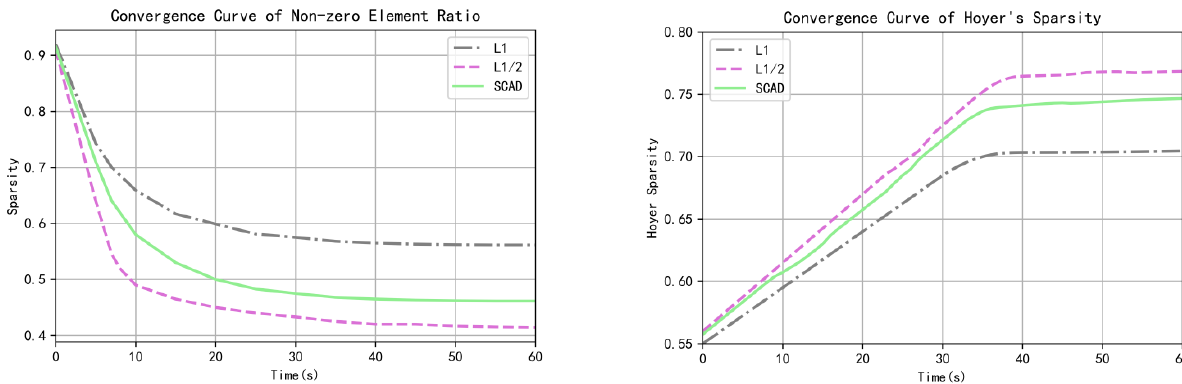
Figure 5. Convergence curve of sparsity of the first convolution layer sparse vector matrix.